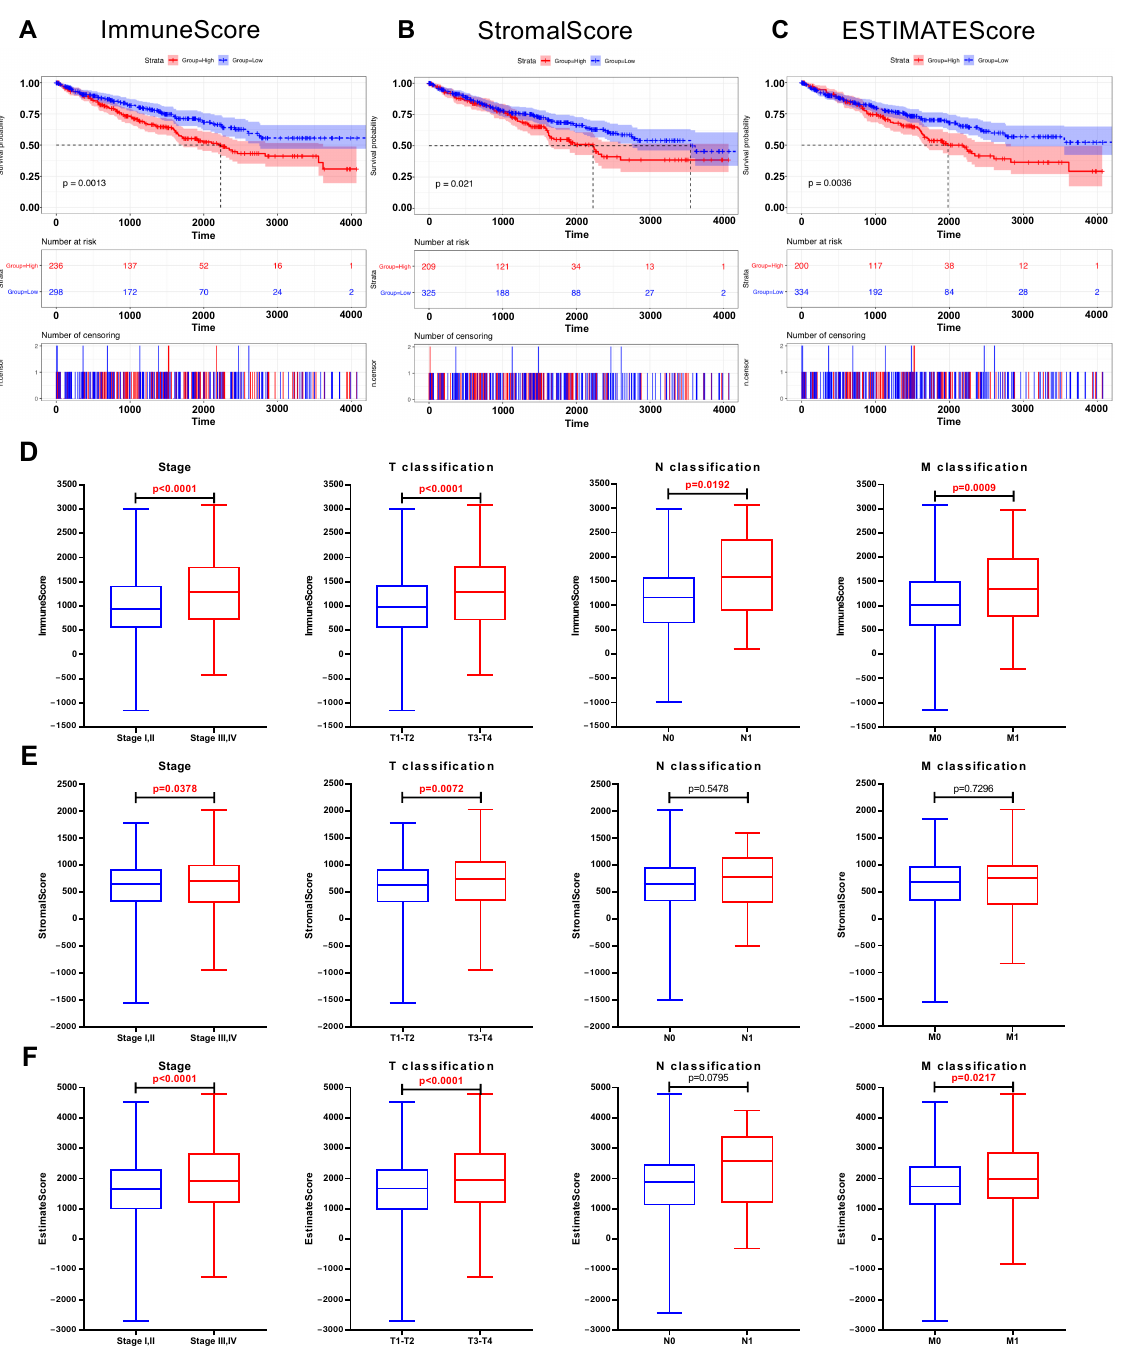
Figure 2. The correlation between scores and the clinicopathological features of KIRC patients. ( A ) Kaplan–Meier survival analysis for ccRCC patients stratified by ImmuneScore into high or low score ( p = 0.001). ( B ) Kaplan–Meier survival curve for KIRC patients with high StromalScore and low StromalScore ( p = 0.021). ( C ) Survival analysis for ccRCC patients stratified by ESTIMATEScore ( p = 0.004). ( D ) Distribution of ImmuneScore in subgroups (stage I, II vs. stage III, IV; T1, 2 vs. T3, 4; N0 vs. N1; and M0 vs. M1). The p < 0.0001, < 0.0001, 0.0192, and 0.0009, respectively, by Wilcoxon rank sum test. ( E ) Distribution of StromalScore in subgroups of stage, T classification, N classification, and M classification ( p = 0.0378, 0.0072, 0.5478, and 0.7296, respectively, by Wilcoxon rank sum test). ( F ) Comparation of ESTIMATEScore between different stage ( p < 0.0001), T classification ( p < 0.0001), N classification ( p = 0.0795), and M classification ( p =